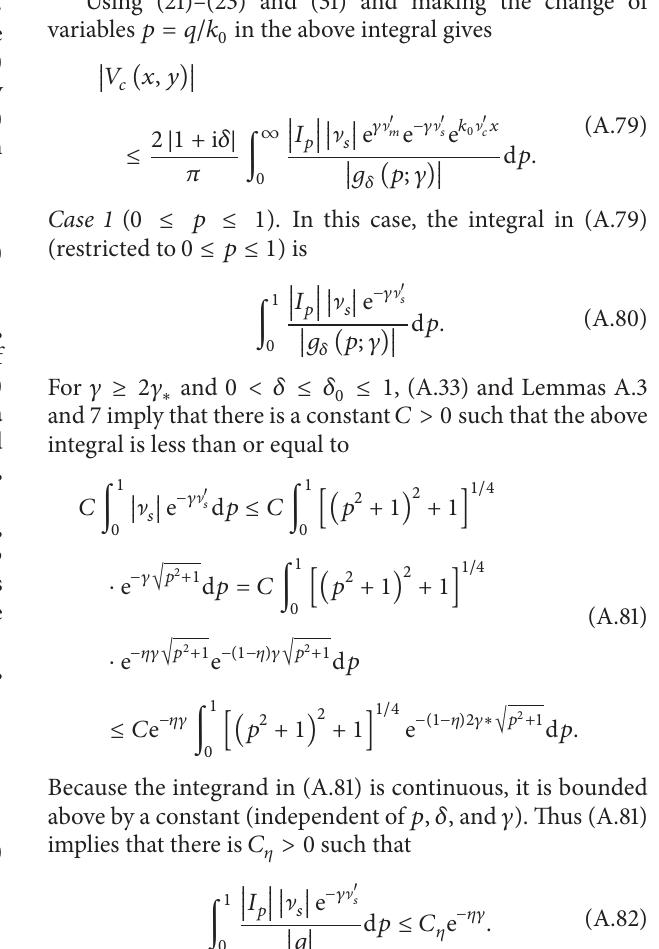
Figure 14: This figure contains a plot of the expression on the right-hand side of (A.48). In both plots, the blue dashed curve corresponds to 𝛾 = (3/2)𝛾 𝛾 = 𝛾 ∗ , the red dotted curve corresponds to ∗ , and the yellow solid curve corresponds to expression in (A.48) over the intervals (a) 1 ≤ 𝑝 ≤ 7 and (b) 7 ≤ 𝑝 ≤ 10